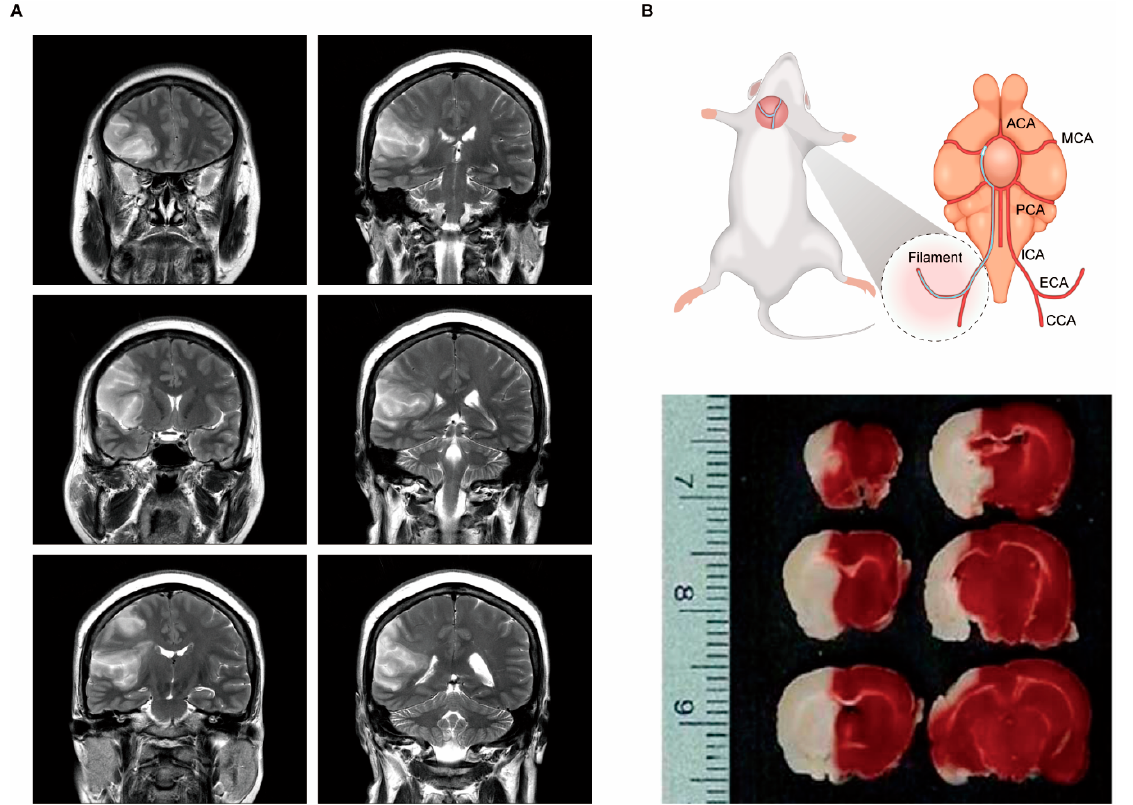
Figure 1. ( A ) Coronal T2 weighted images. High signal intensity indicates cerebral infarction in the middle cerebral artery (MCA) territory from a patient with occlusion of M1 of MCA and mild stenosis of the proximal cervical internal carotid artery with fibrofatty plaque. Coronal T2 weighted magnetic resonance images were acquired using a clinical 3T scanner (GE Healthcare, Signa pioneer, USA) with a 24-channel coil, and the following parameters: repetition time (TR) 5745 ms; echo time (TE)